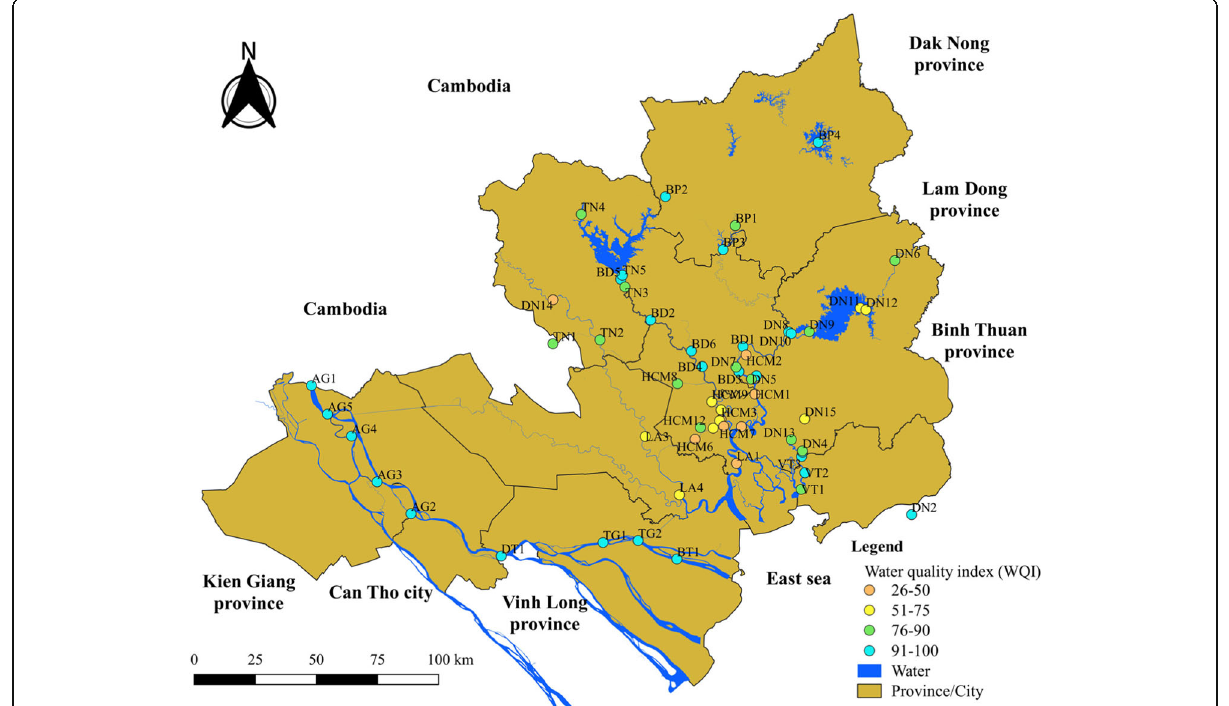
Fig. 3 Distribution of WQI at the monitoring